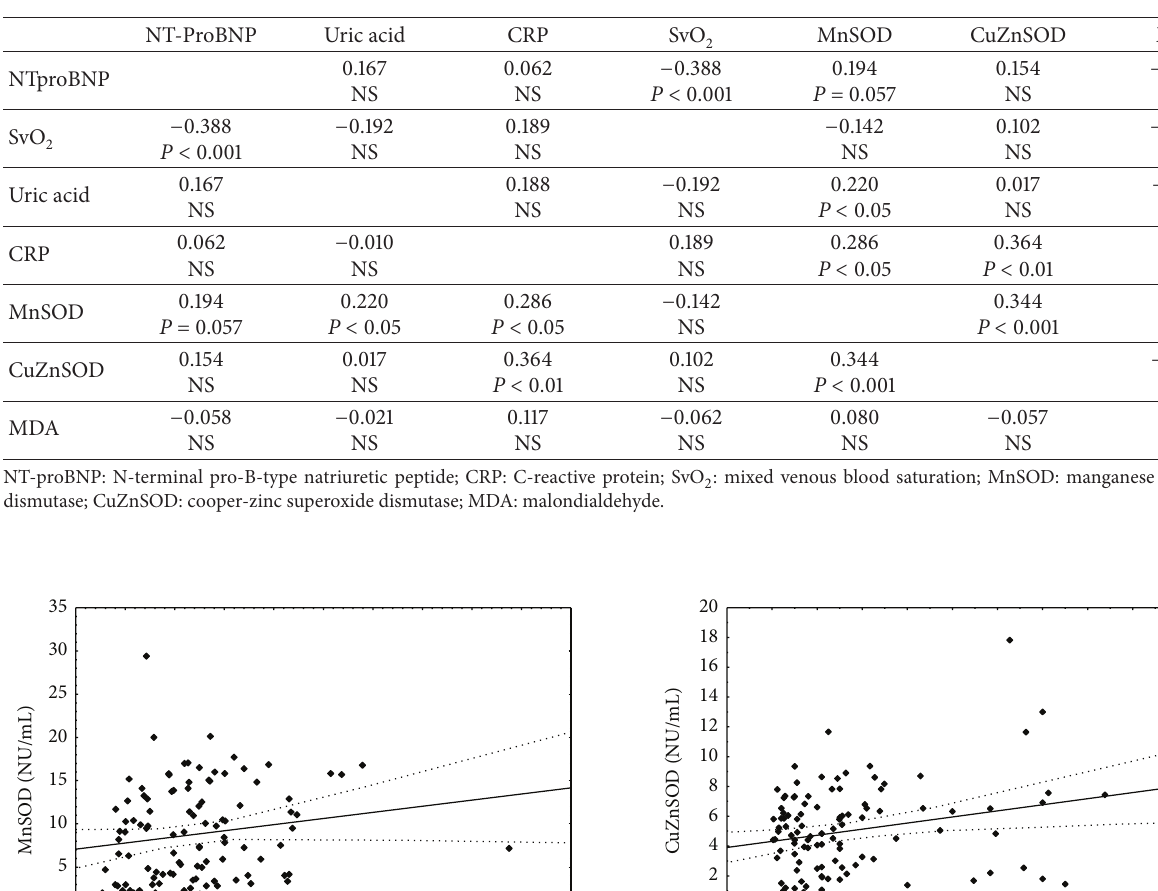
Table 6: Spearman 𝑟 correlation between biomarkers.